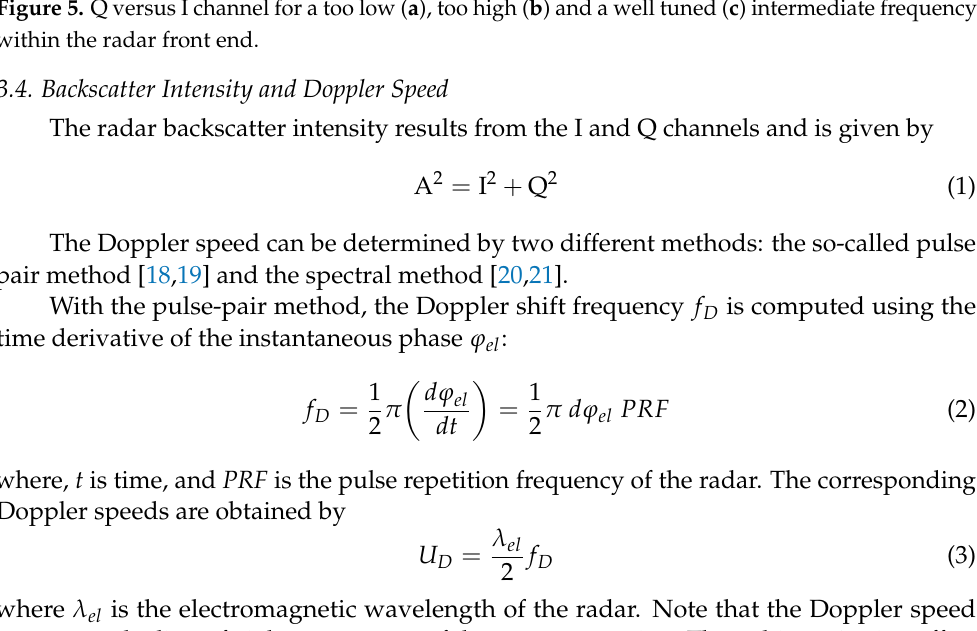
Figure 5. Q versus I channel for a too low ( a ), too high ( b ) and a well tuned ( c ) intermediate frequency within the radar front end.